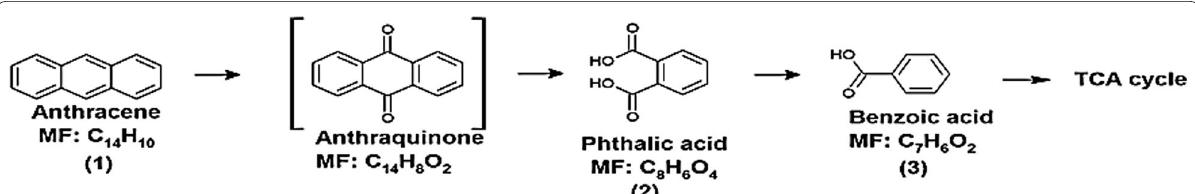
Fig. 4 Proposed pathway for anthracene biodegradation by Brevibacillus sp. as suggested by the GC–MS data analysis. The compound in brackets was not detected